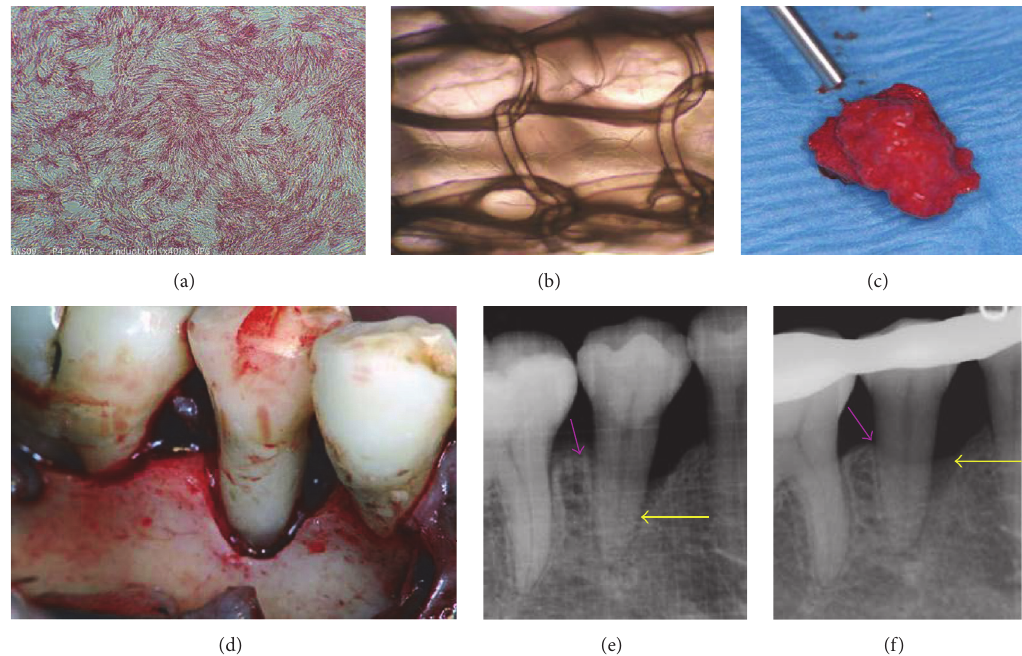
Figure 2: (a) Positive alkaline phosphatase staining of osteoinduced BMMSCs. (b) BMMSCs proliferate on the basket-shaped scaffold. (c) The combination of BMMSCs/PRP and thrombin in calcium chloride generates a gel-like structure. (d) Representative image of the periodontal intrabony defect (preoperative). (e, f) X-ray images taken before and 8 weeks after the surgery.